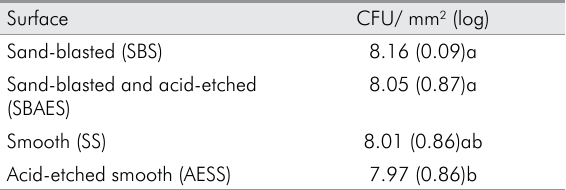
Table. Average bacterial counts (SE) on titanium surfaces submitted to different